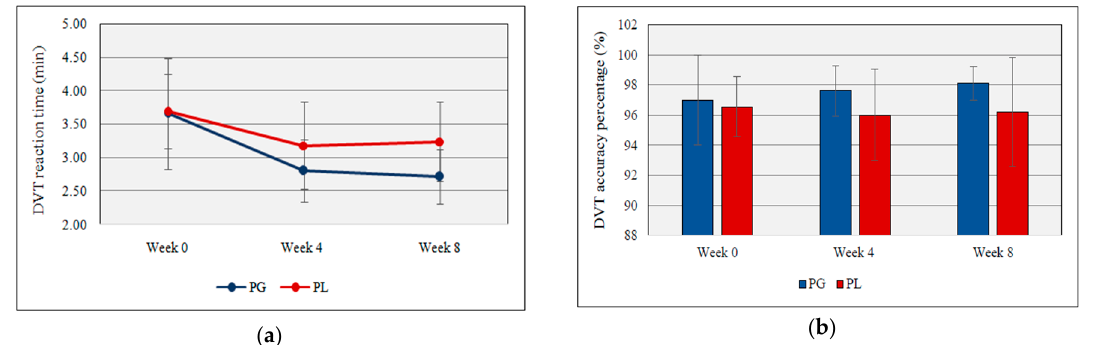
Figure 3. ( a ) DVT reaction time during the study period; ( b ) DVT accuracy percentage during the study